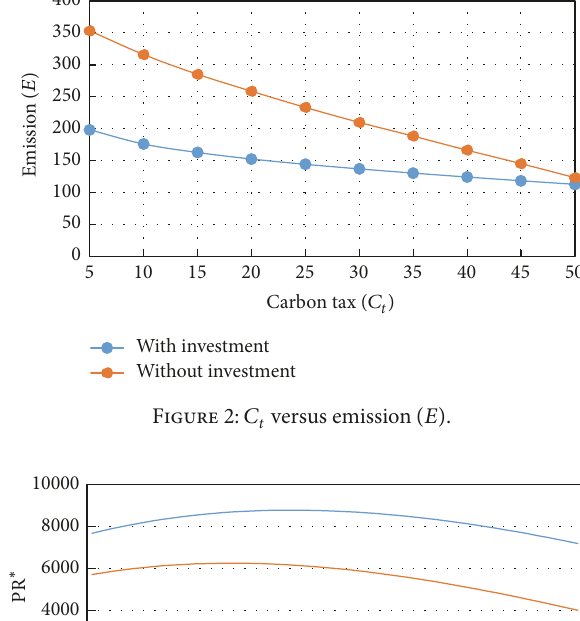
Figure 2: 𝐶 𝑡 versus emission (𝐸) .